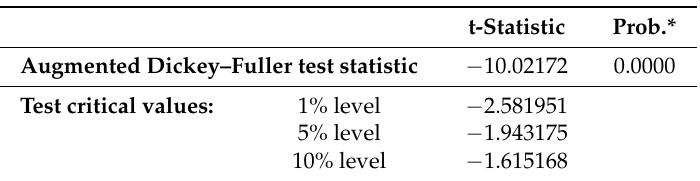
Table 8. ADF test result after differential sequence.